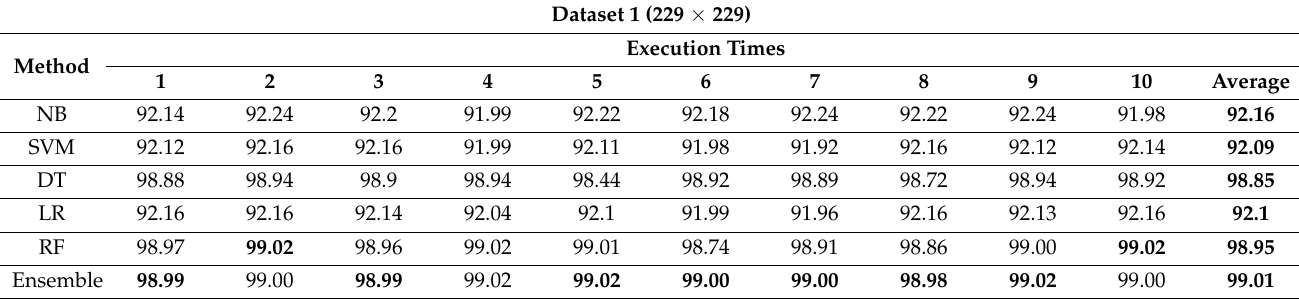
Table 9. Average performance comparison with multiple